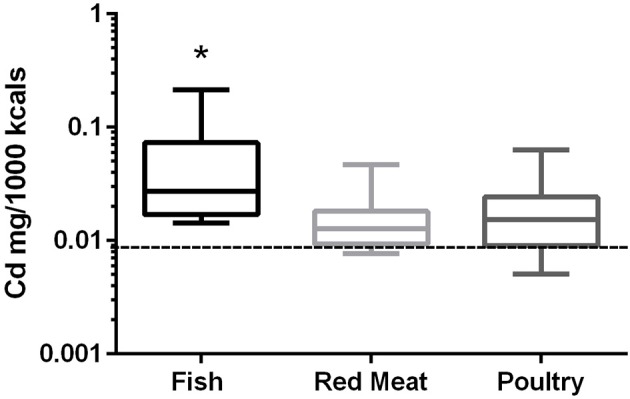
Box-and-whisker plots of the log cadmium concentrations in fish, poultry, and red meat-based dry dog foods (17 dog foods representing each for animal based protein source). Boxes represent the 25 and 75th percentiles, and whiskers represent the minimum and maximum. Solid lines within boxes represent the median values. Dashed lines indicate human intake (mg/Mcal) based on mean daily consumption. *indicates a significant difference from both red meat and poultry based diets (p < 0.01).